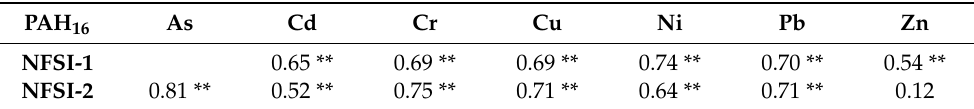
Table 2. Correlation coefficients between PAH 16 concentration and the As, Cd, Cr, Cu, Ni, Pb and Zn concentrations in the humus layers of Brandenburg NFSI sites differentiated for data from NFSI-1 (n = 36) and NFSI-2 (n = 50); significance: ** p <